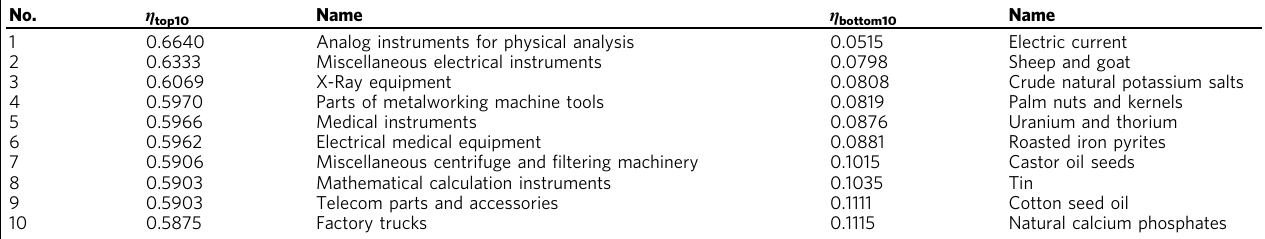
Table 1 The Top 10 and bottom 10 products are ranked by the nestedness.